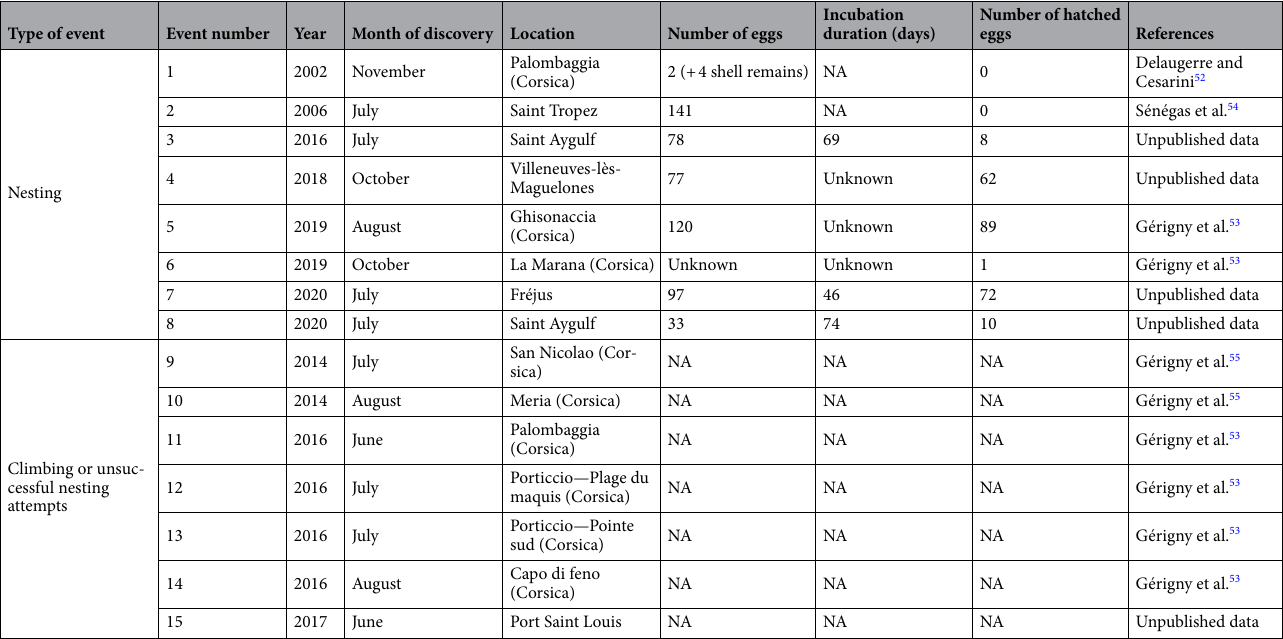
Table 1. Nesting activity reported between 2002 and 2020. The year and month of discovery, location, number of eggs recorded, incubation duration, number of hatched eggs and relevant references are indicated. Event numbers refer to locations represented on Fig. 5.